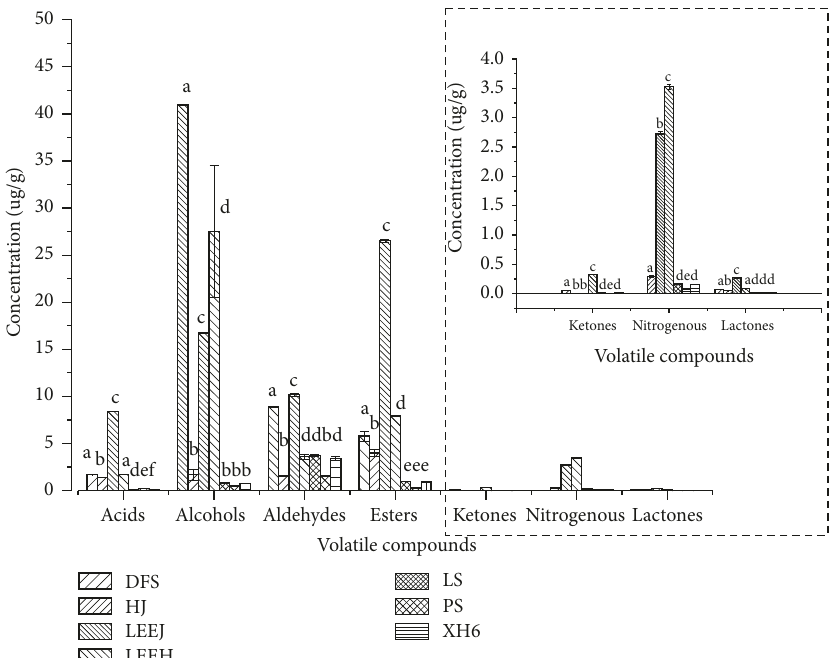
Figure 2: The compositions of volatile compounds in SFFPs. Bars show the mean ( ± SD) of duplicate analysis from GC-MS data. Different letters near the bar indicate significant differences ( 𝑝 < 0.05 ). Enlargement of the box (dashed line) is displayed for the differences in ketones, nitrogenous compounds, and lactones. Different letters represent a significant difference ( 𝑝 < 0.05